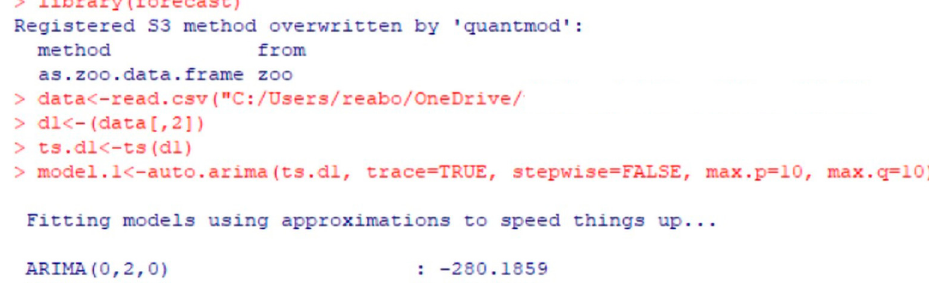
Figure 5. Prediction results of the ARIMA model.